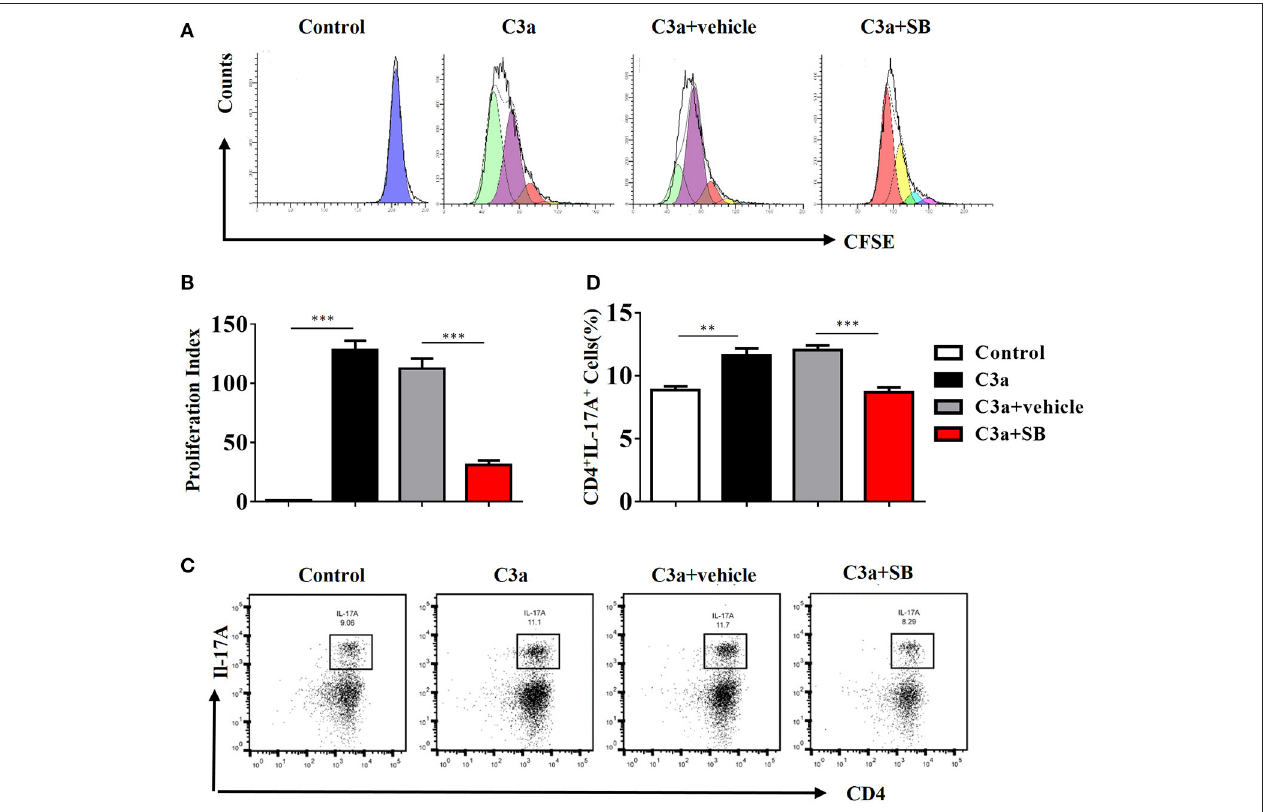
FIGURE 8 | C3a acts as regulator for renal IL-17A. Splenocytes stimulated with recombinant C3a (20nM) for 72h in the presence or absence of SB290157. (A) Average T cell proliferation increased in response to mC3a, while T cell proliferation decreased in SB290157-treated cultures compared to those containing only mC3a. (B) The histograms show the blockade of C3a drastically suppressed T cell proliferation stimulated with C3a. The error bars represent the SEM. *** P < 0.001. (C) Splenocytes were double-stained for CD4 and IL-17A. Representative dot plots are presented, and the numbers in the quadrants represent the percentage of each population. (D) Quantifications of CD4 + IL-17A + cells as percentages of splenocytes isolated from the WT mice. The error bars represent the SEM. ** P < 0.01; *** P < 0.001. The data were pooled from three independent